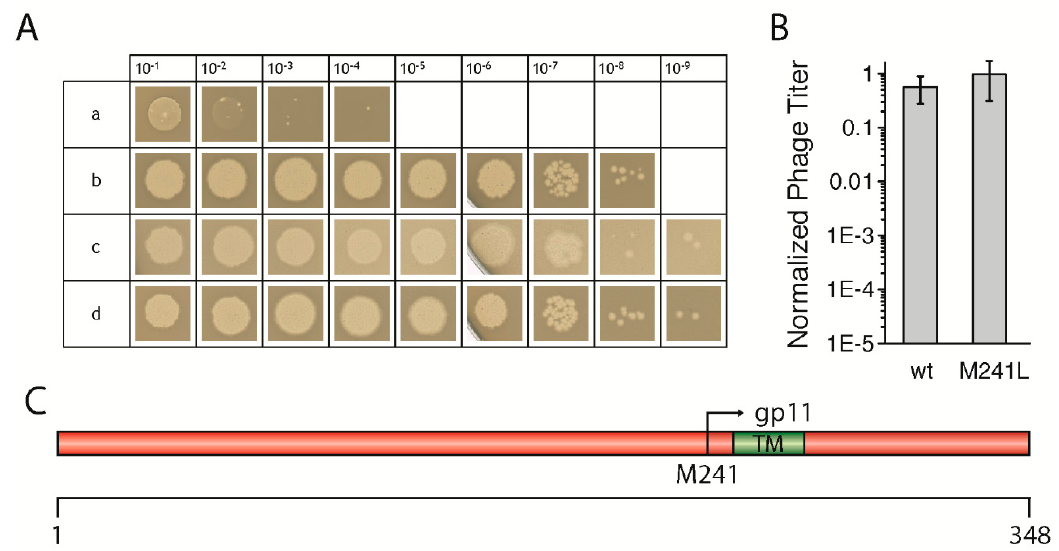
Figure 1. ( A ) Representative “spot assay” in which serial dilutions of phages were spotted on a bacterial lawn in order to analyse the amount of complementation compared to the